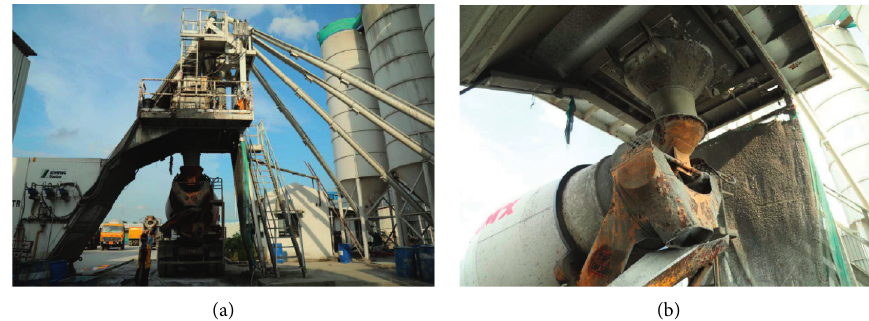
Figure 1: (a) Mixing unit in the RMC plant. (b) Discharge of concrete from the mixer to the